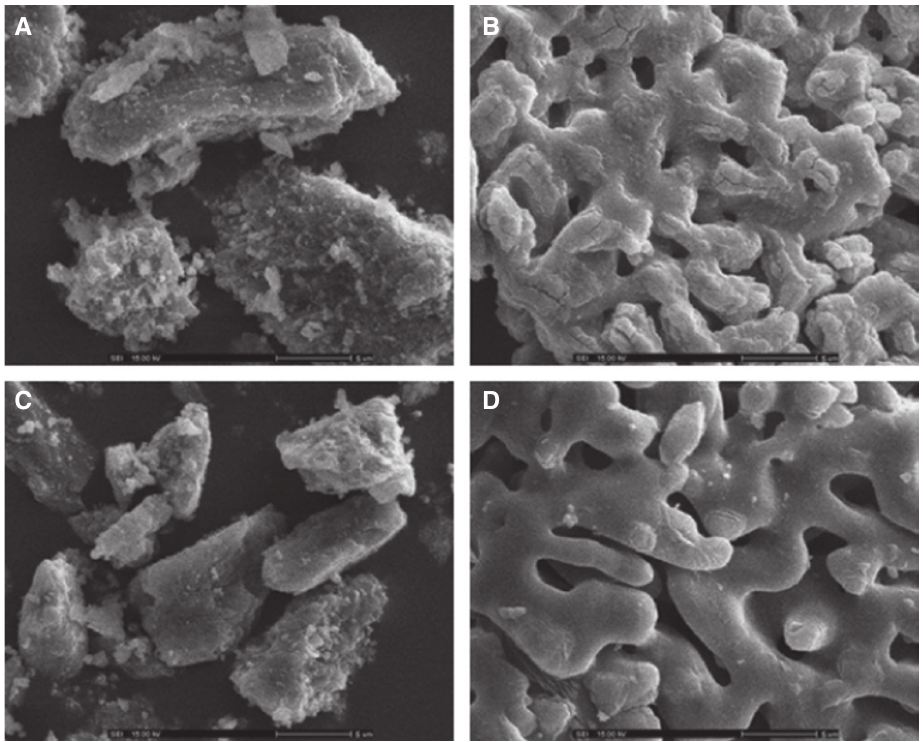
Figure 5: Scanning electron microscopy (SEM) images of (A) natural razor clam shell, (B) calcined razor clam shell, (C) natural surf clam shell, and (D) calcined surf clam shell.